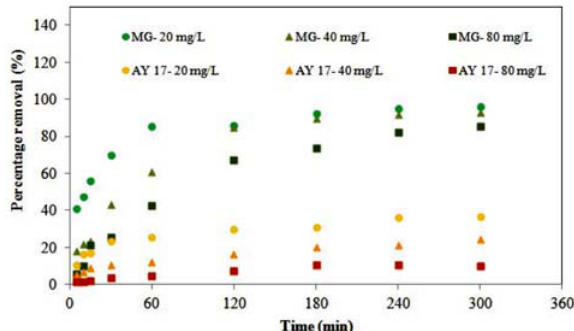
Figure 8. Effect of initial dye concentration and contact time in the removal of MG and AY 17